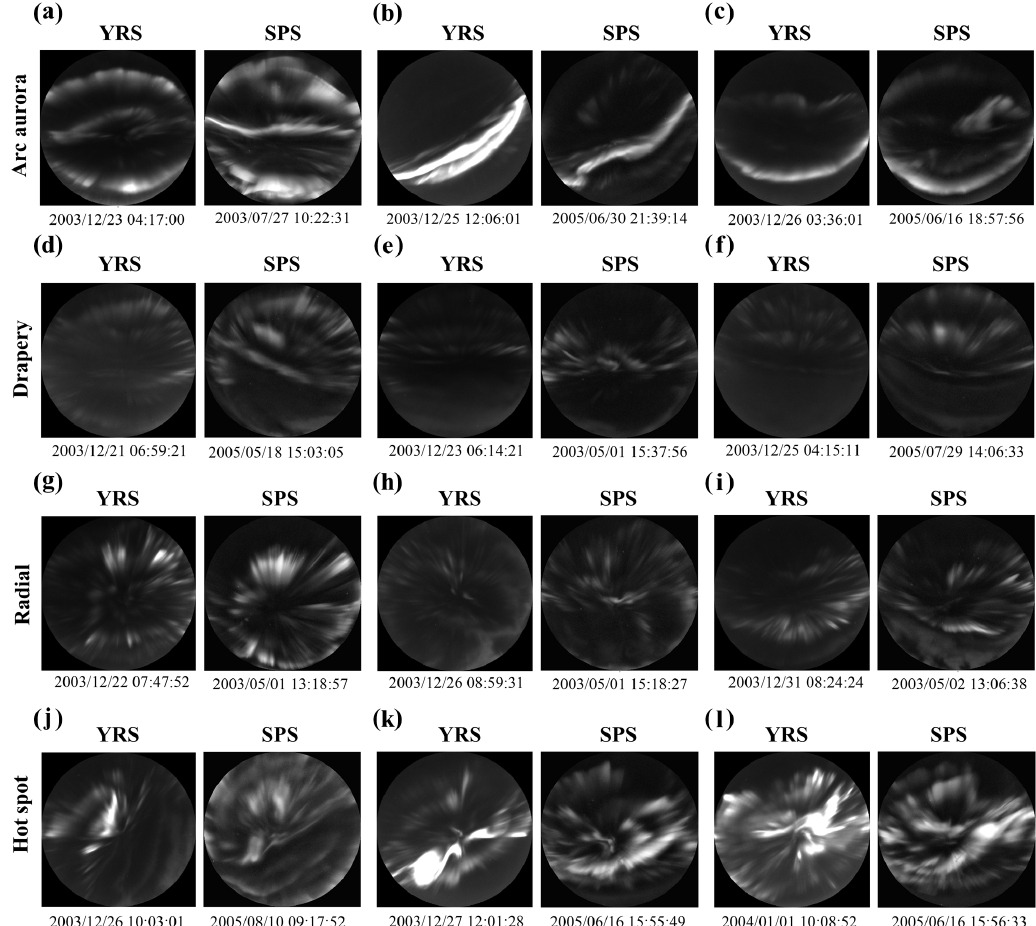
Figure 3. Comparison of the four auroral types at SPS and YRS by retrieval experiments. The images from labeled ARD of YRS are used as query images, and the images of SPS are the retrieval results from ATD1 which are the most similar to each query image.